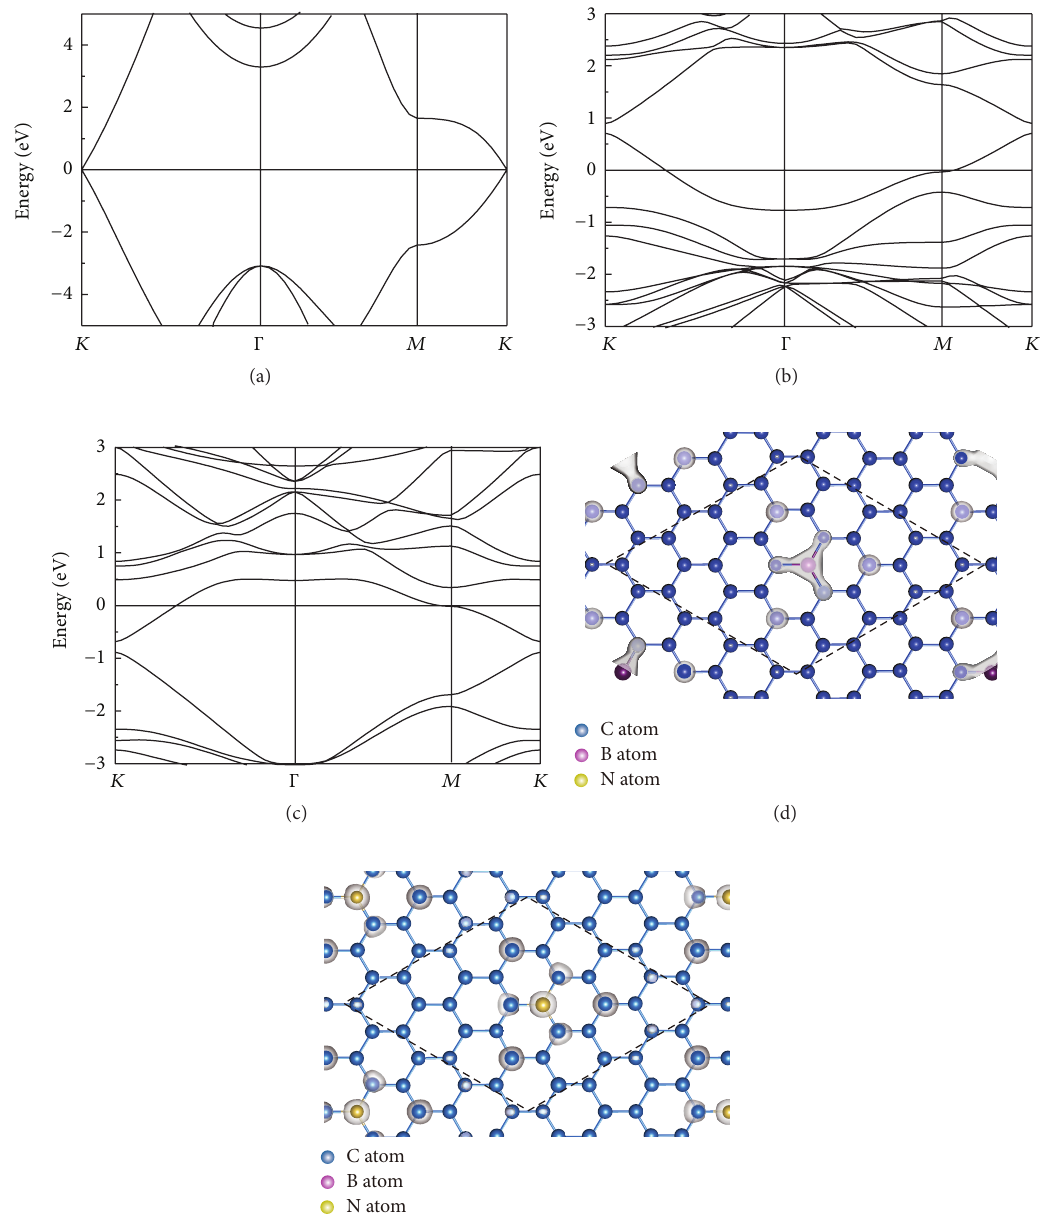
Figure 4: Energy-band structures of (a) pristine, (b) B-doped, (c) N-doped graphenes, and the isosurfaces of electron-state densities related to (d) B and (e) N defects in monolayer graphene. The isosurface value of electron density is set to 0.03 electron/˚A be zero. The energy bands of the pristine graphene are plotted using 1 × 1 unit cell, whereas those of B(N-) doped graphene are plotted using 4 × 4